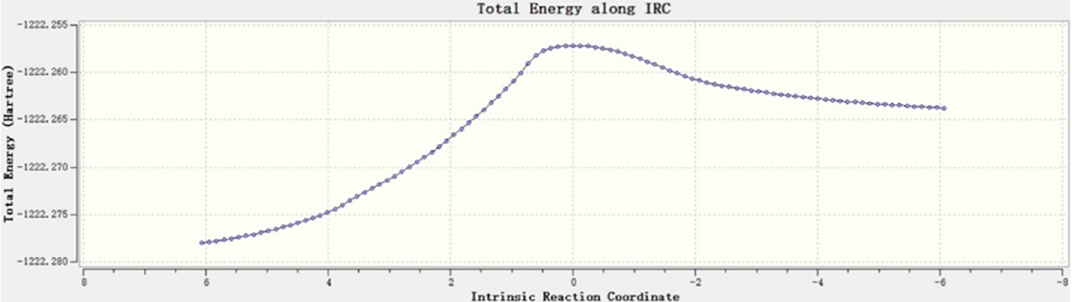
Figure 3. The intrinsic reaction coordinate calculation. The intrinsic reaction coordinate is plotted against the total energy of the system. The energy peaks at the transition state.